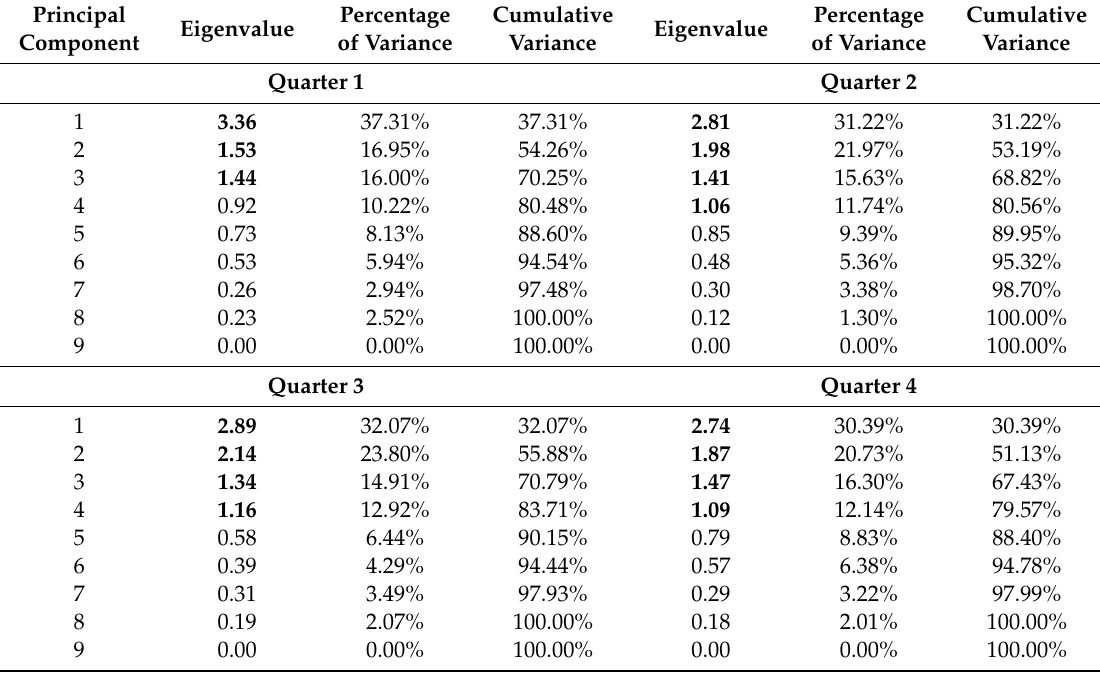
Table 4. Results of principal component analysis comprising 9 variables ( E. coli concentration, water temperature, pH, SPC, DO, chloride, percentage of agricultural land use, percentage of forested land use and percentage of developed land use) used to define 9 principal components, displaying eigenvalues, percentage of variance and cumulative variance during quarter one (winter: 2